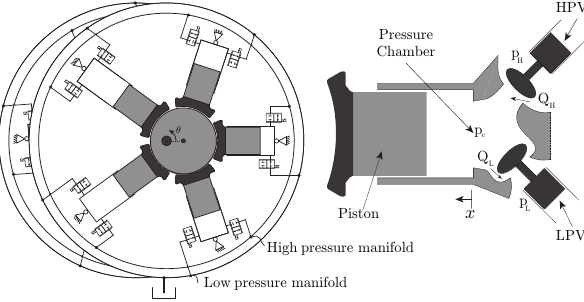
Figure 1: Illustration of the displacement pump-motor